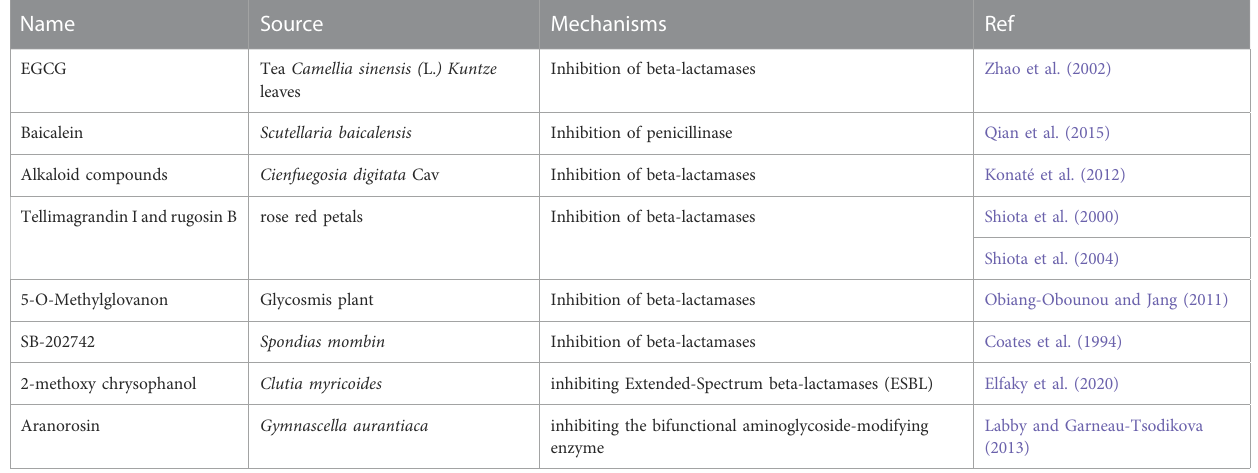
TABLE 3 The compounds from natural products that affect beta-lactamases and other hydrolytic